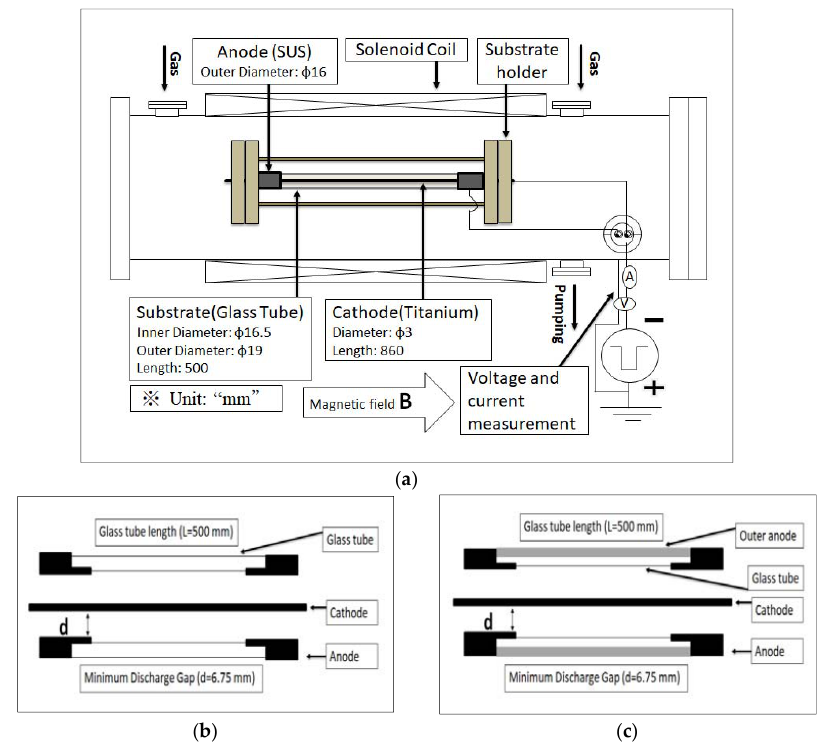
Figure 1. Experimental apparatus: ( a ) overall setup; ( b ) details of the edge anode; and ( c ) details of the outer anode. The white parts indicate the glass tube and the black parts at the edge of the glass tube represent the ring anodes.